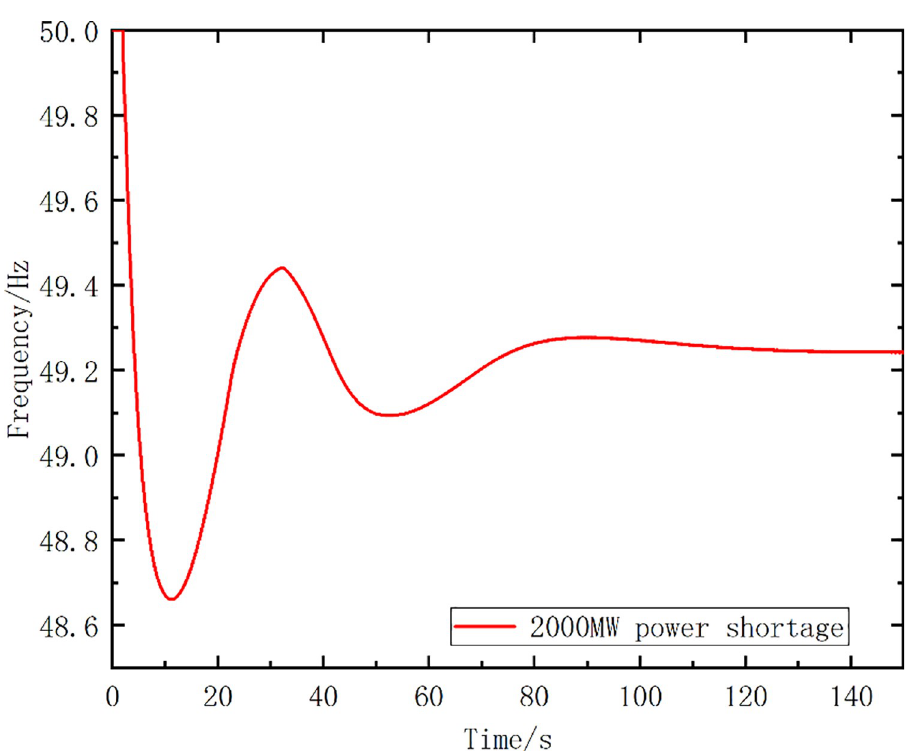
Fig 15. Frequency variation for the 2000 MW power shortage scenario, without any recovery strategy applied.